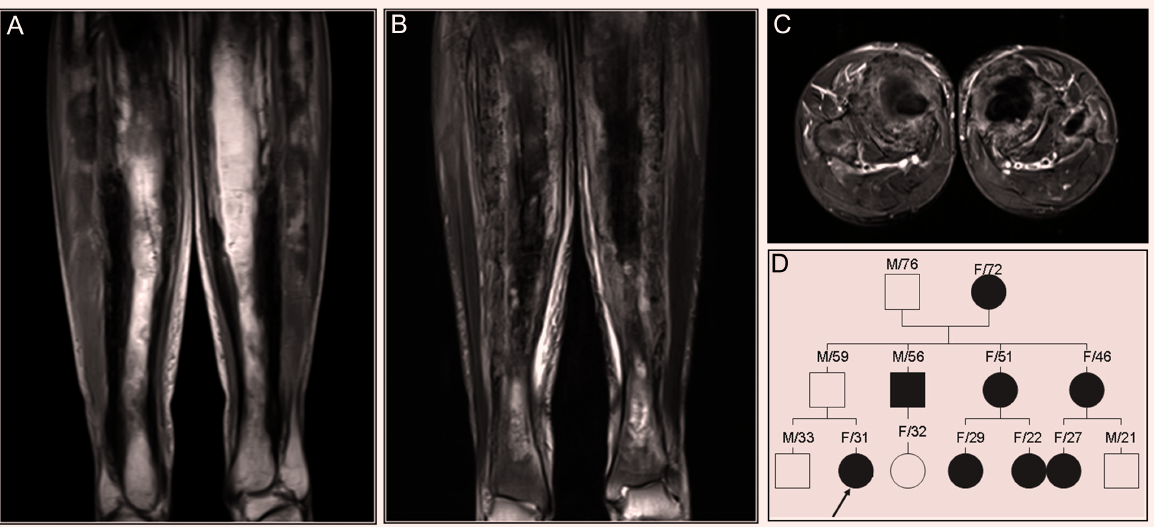
Figure 6. Patient 4: ( A ) MRI images of the both femora showed thickened cortices with low SI on T1 WI ( A ) and heterogenous SI on T2 fat suppression WI ( B , C ). ( D ) Family pedigree of the patient’s family, indicating an autosomal dominant mode of inheritance. Arrow indicates the index case, dark circle is affected individual, and gray square is asymptomatic